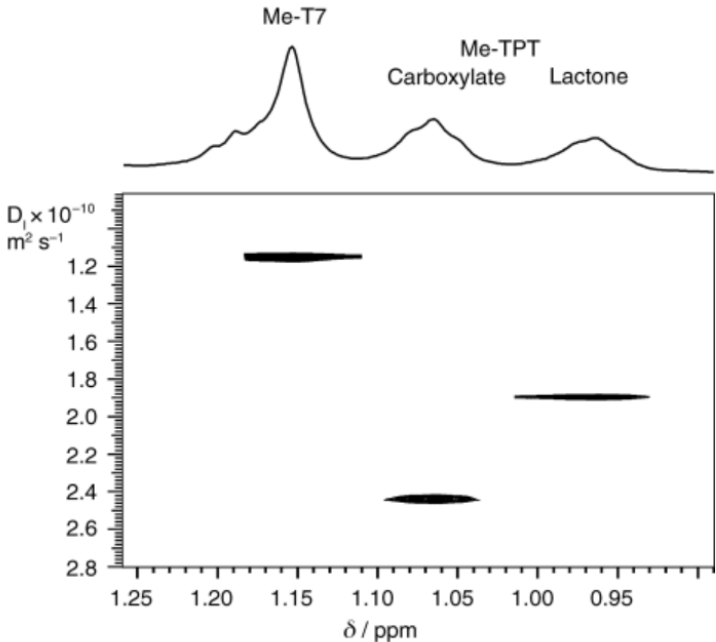
Figure 9. A DOSY spectrum showing diffusion coefficient versus methyl chemical shift for Topo- tecan with a nicked decamer. Taken from Ref. [32], with permission from WILEY-VCH Verlag. It is seen that the carboxylate form forms a weaker complex with the decamer-DNA than the lactone form.